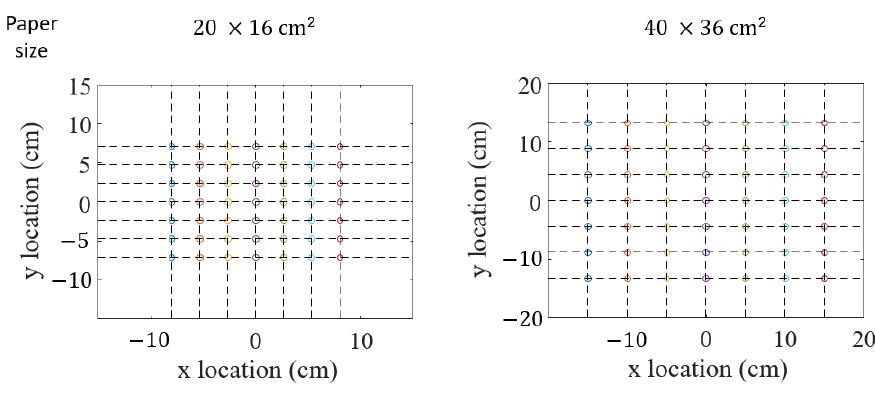
Figure 2. Points marked on the 20 × 16 and 40 × 36 cm 2 paper.